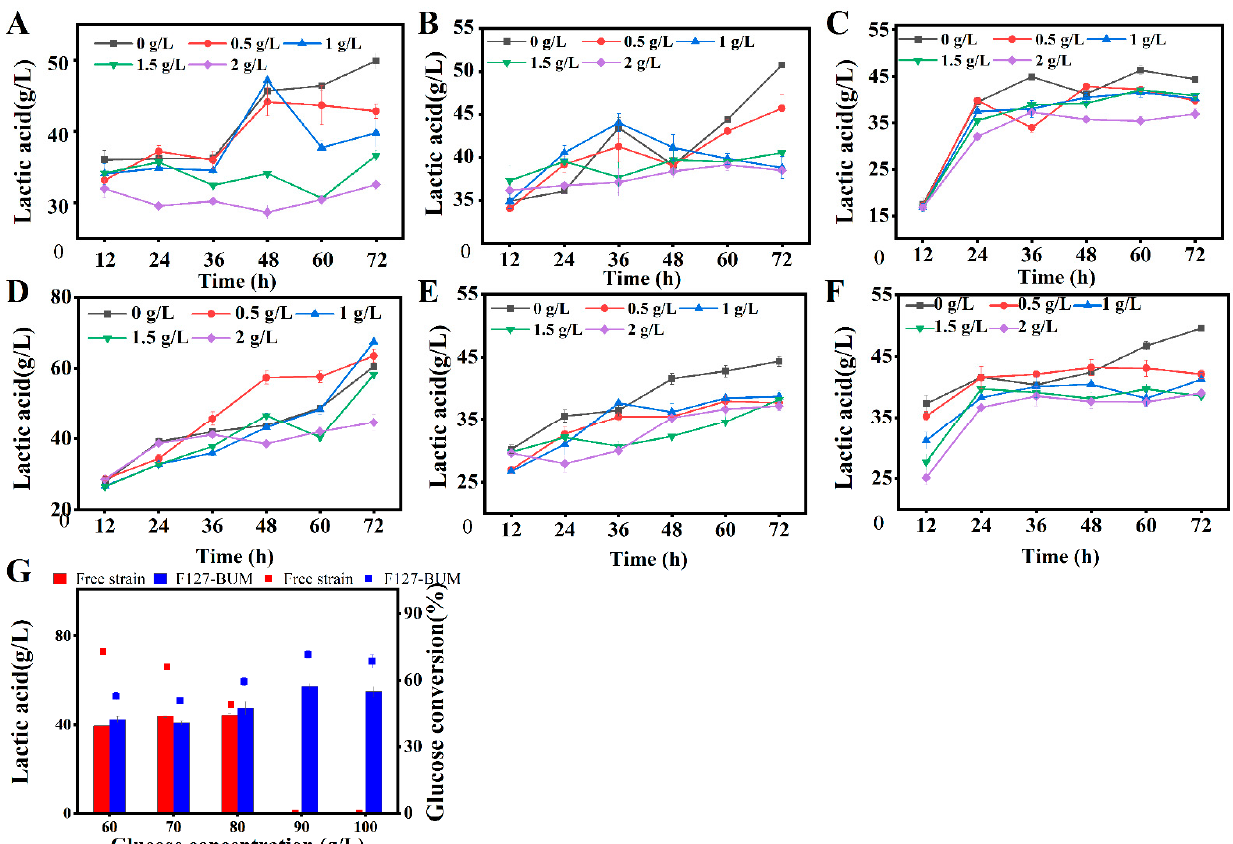
Figure 3. Tolerance analysis of 5-HMF by free-living fermentation ( A ) and F127-BUM microencap- sulated colloids ( D ), FA by free-living fermentation ( B ) and F127-BUM microencapsulated colloids ( E ), Vanillin by free-living fermentation ( C ) and F127-BUM microencapsulated colloids ( F ), and F127-BUM microencapsulated colloids in a high glucose concentration environment ( G ). Immobilized T15 at different glucose concentrations showed the yield of D-LA and the conversion rate of D-LA and glucose.